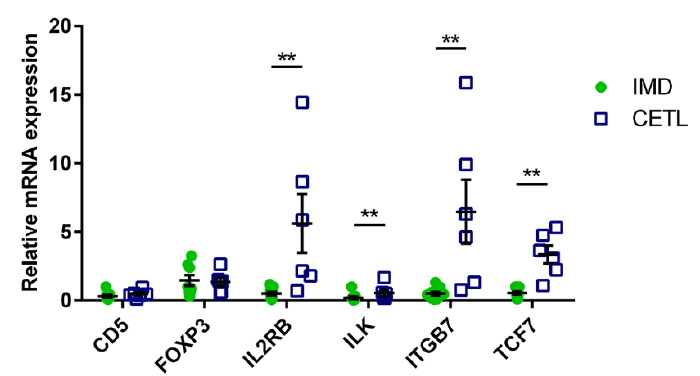
Figure 3. Relative mRNA expression of selected genes resulting from RT-qPCR. IMD cases depicted as green dots, CETL cases as blue squares; whiskers indicate the standard deviation of the mean; ** p < 0.05. The outliers in the IL2RB and ITGB7 measurements are cases no. 3 and 8, and cases no. 8 and 11, respectively.